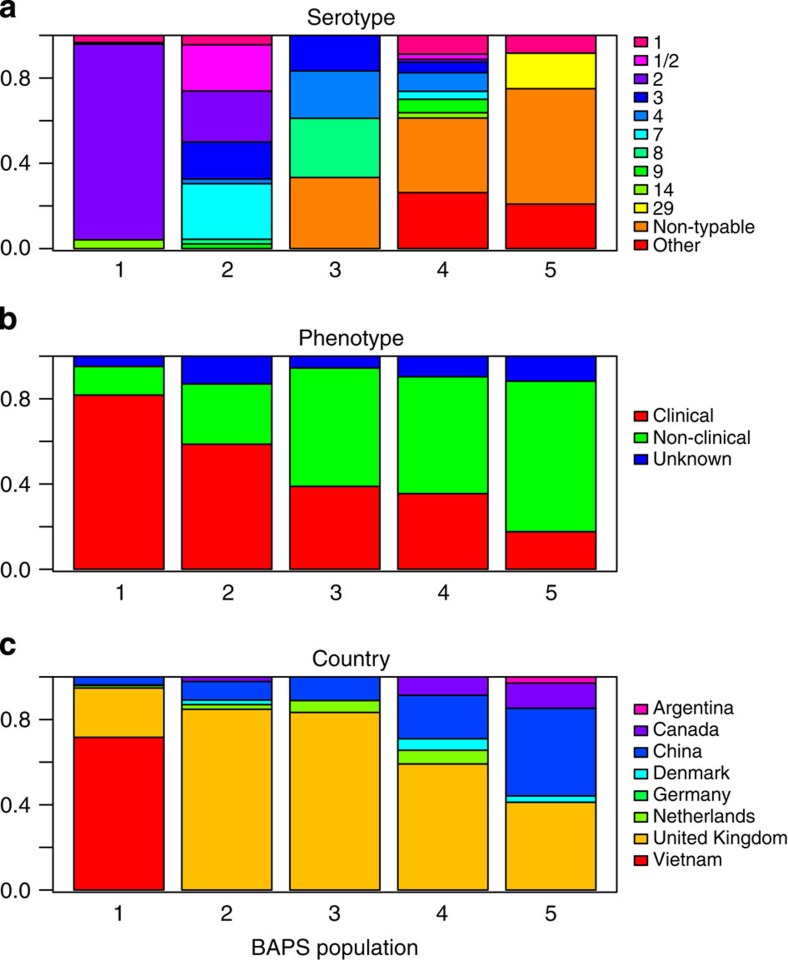
S. suis populations broken down by metadata.The distribution of (a) serotype, (b) clinical phenotype and (c) country of origin, among the five populations of S. suis that were identified by our Bayesian analysis of population structure. The figures show that there is little genetic structure with regard to the metadata, although a partial exception is population 1, which is dominated by isolates from Vietnam, and serotype 2, and which contains all the zoonotic isolates.